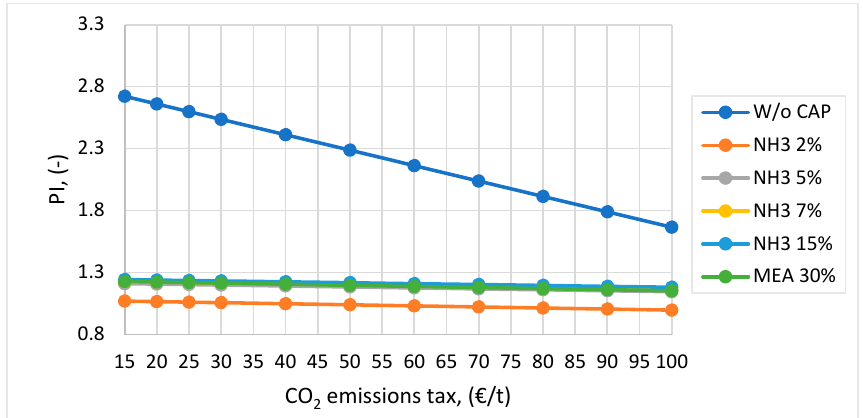
Figure 7. DPP with and without the CO 2 capture process according to the CO 2 emissions tax.